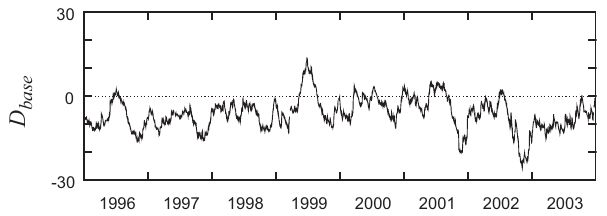
Fig. 3. Estimated variation of D base from 1996 to 2003.